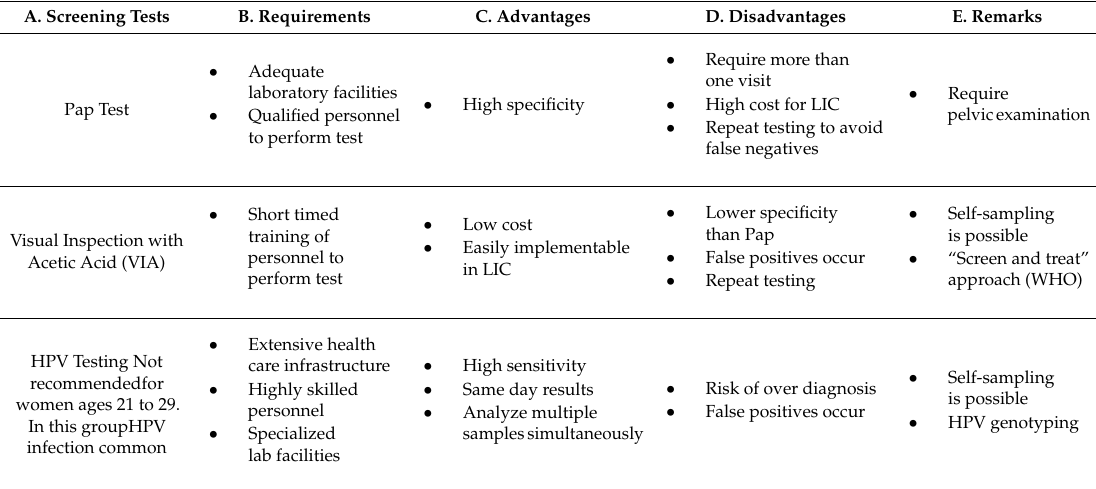
Table 1. Screening tests for cervical cancer with applicability to low-income. counties (LIC). The recommended (USPSTF) age to begin screening is 21